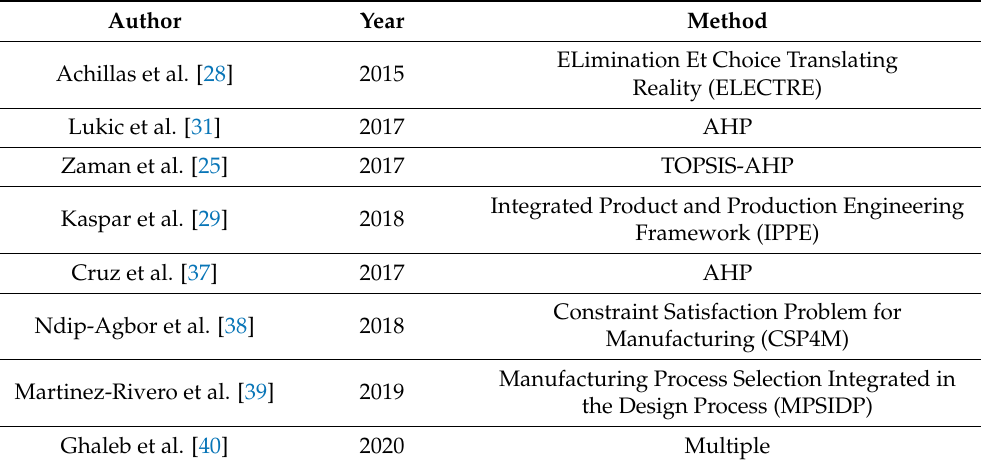
Table 1. Overview of the relevant publications for the present research.